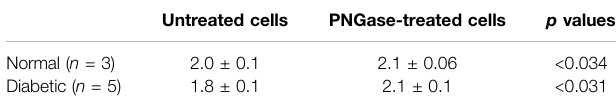
TABLE 2 | Total cellular Mg 2+ content in PNGase-treated red cells. Untreated cells